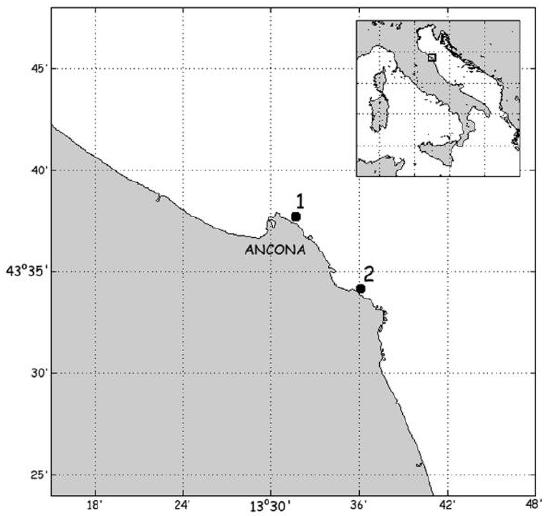
Figure 2. Map of the study area, showing the location of the sampling stations along the Conero Riviera (northern Adriatic Sea). 1: Passetto; 2: Portonovo.